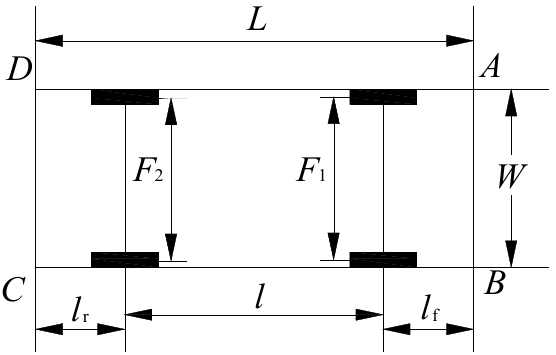
Figure 3. Simplified vehicle model for autonomous parallel parking.